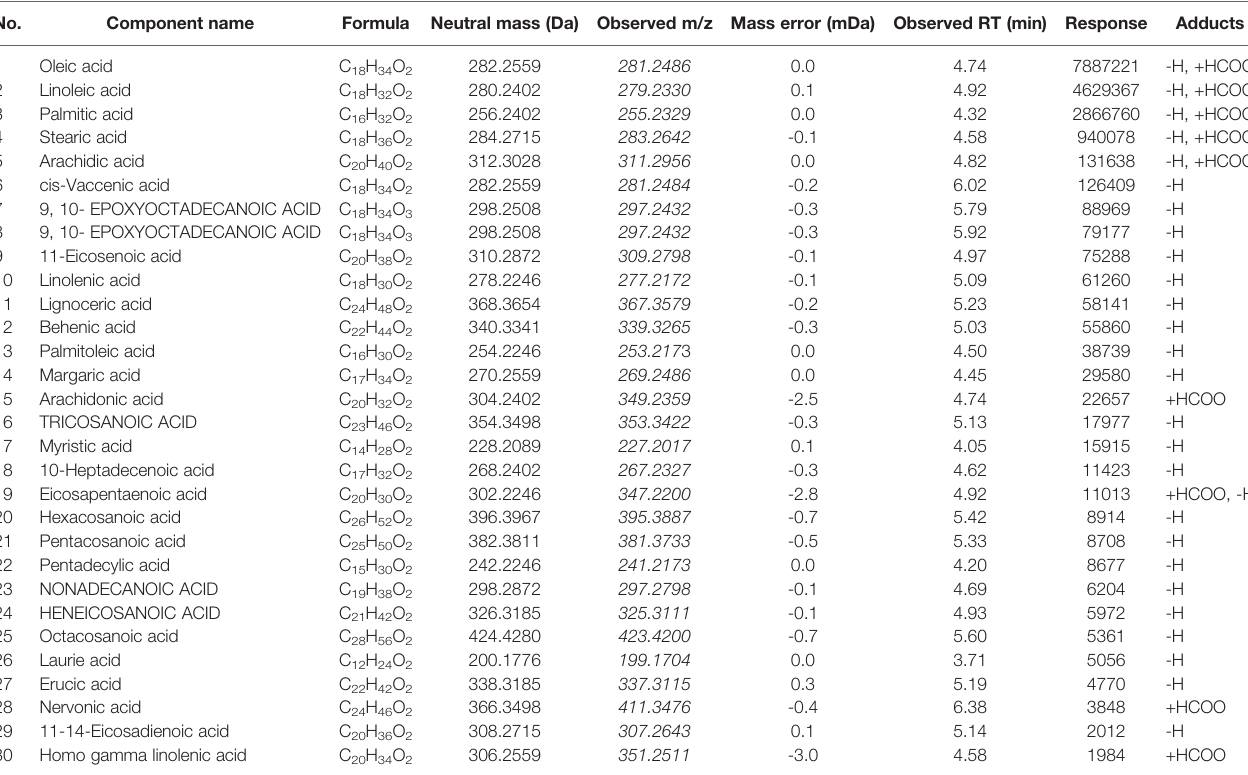
TABLE 2 | The qualitative results free fatty acids in coicis semen oils in ESI - .